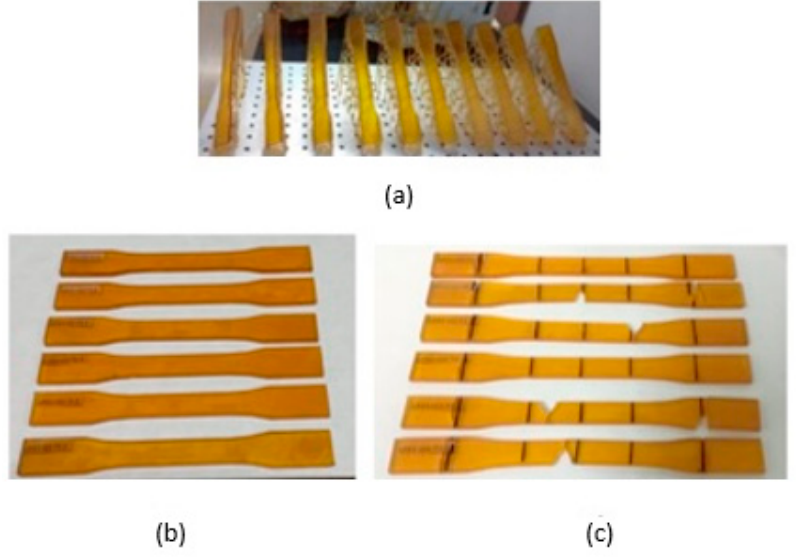
Figure 4. ( a ) ASTM D638 specimens made of DL400 resin obtained in a 3D printer. ( b ) Specimens before failure. ( c ) Failed specimens showing brittle fracture.